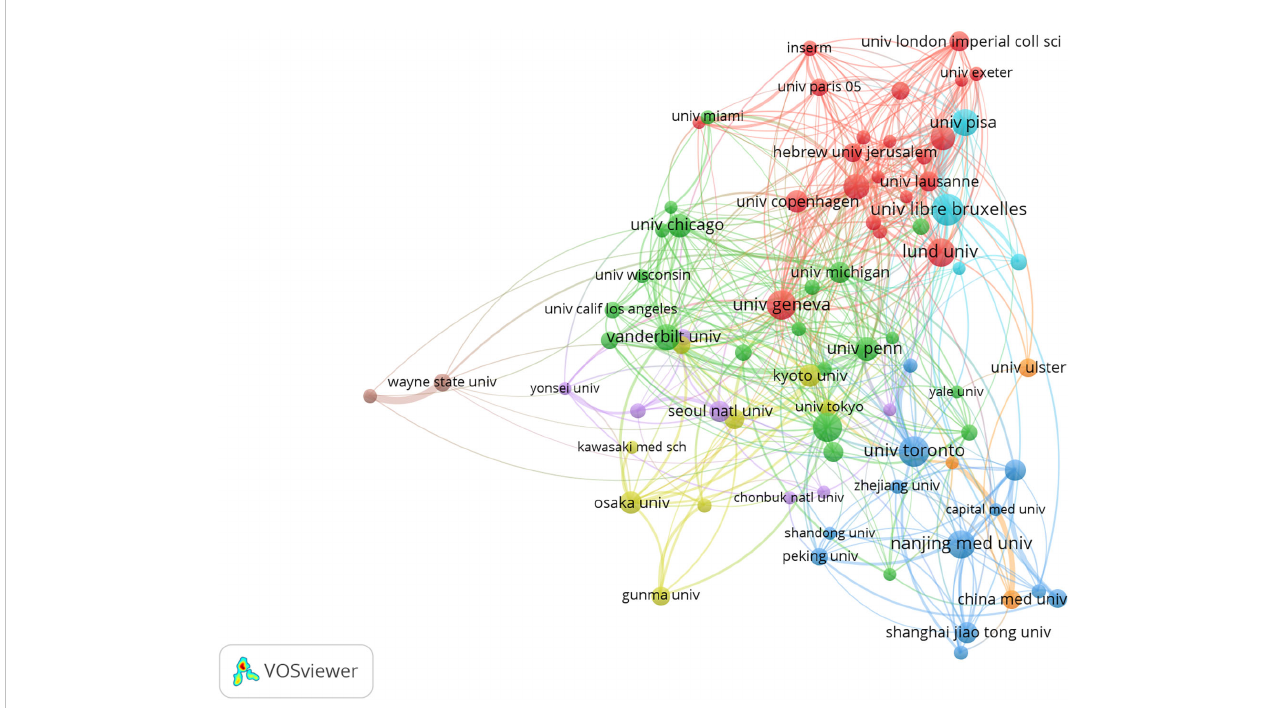
FIGURE 4 The co-occurrence map of institutions in beta-cell research. The total link strength was 633.50; the layout parameters: Attraction: 3, Repulsion: 1. Advanced parameters: Step size reduction: 1. The circle size means the number of publications; the thickness of the line means the strength of the